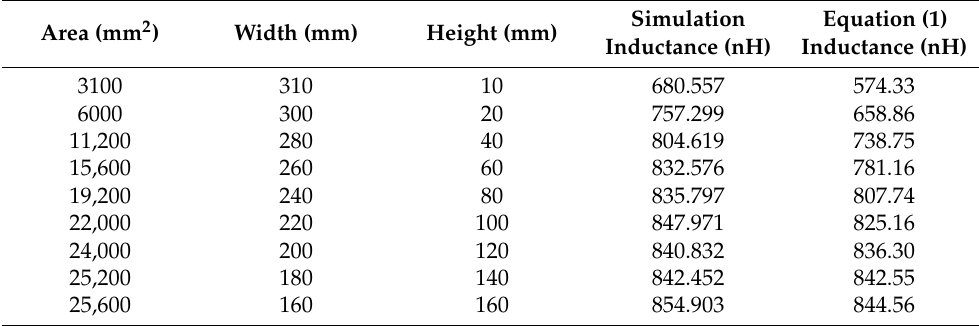
Table 10. Inductance calculation of a single loop rectangle with a constant perimeter (640 mm) using Ansys simulations and Equation (1).